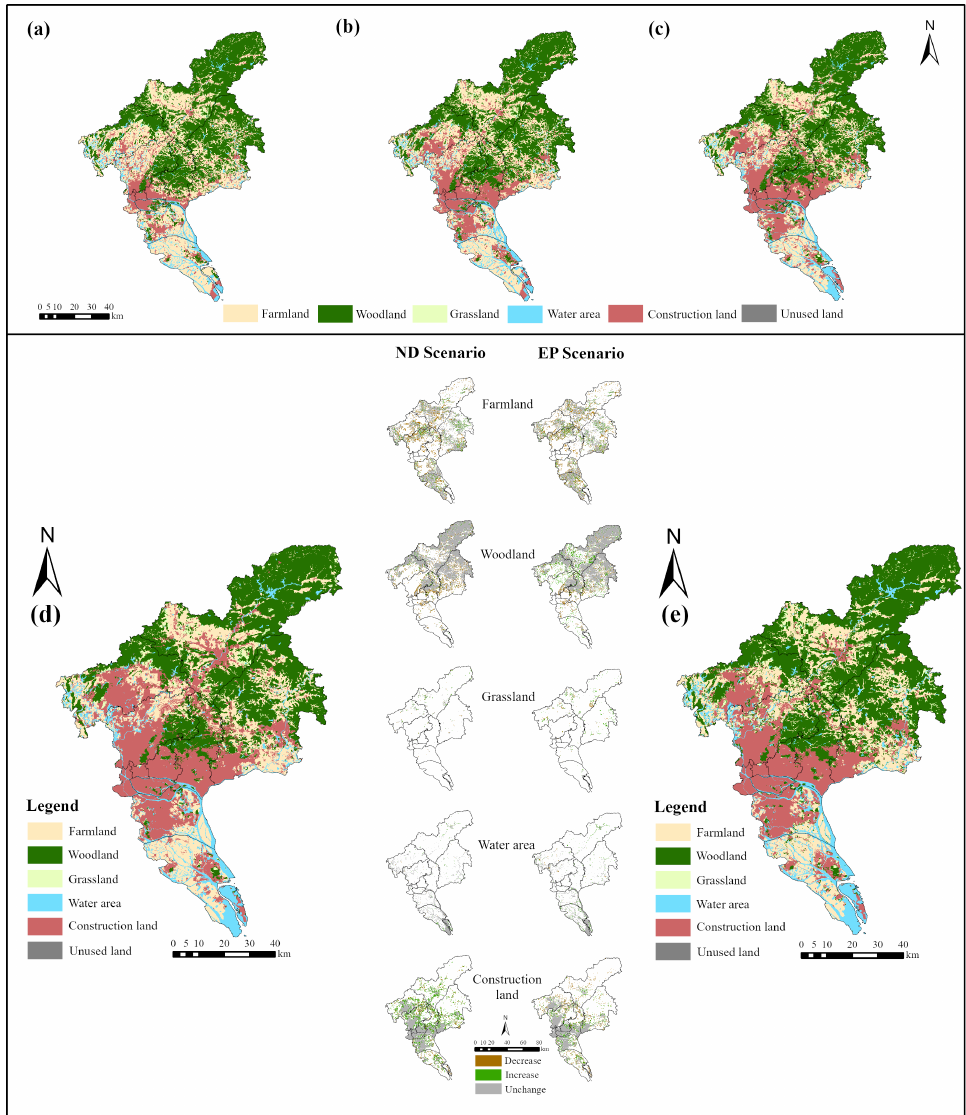
Figure 5. Land use pattern at different time points: ( a ) 2000; ( b ) 2010; ( c ) 2020; ( d ) 2030-ND scenario; ( e ) 2030-EP scenario.